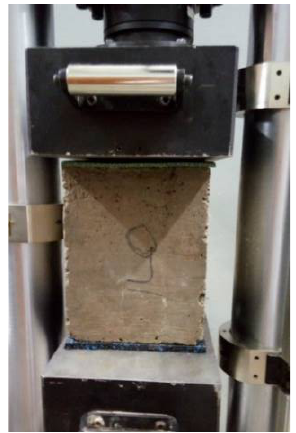
Figure 5 – Compression test in universal